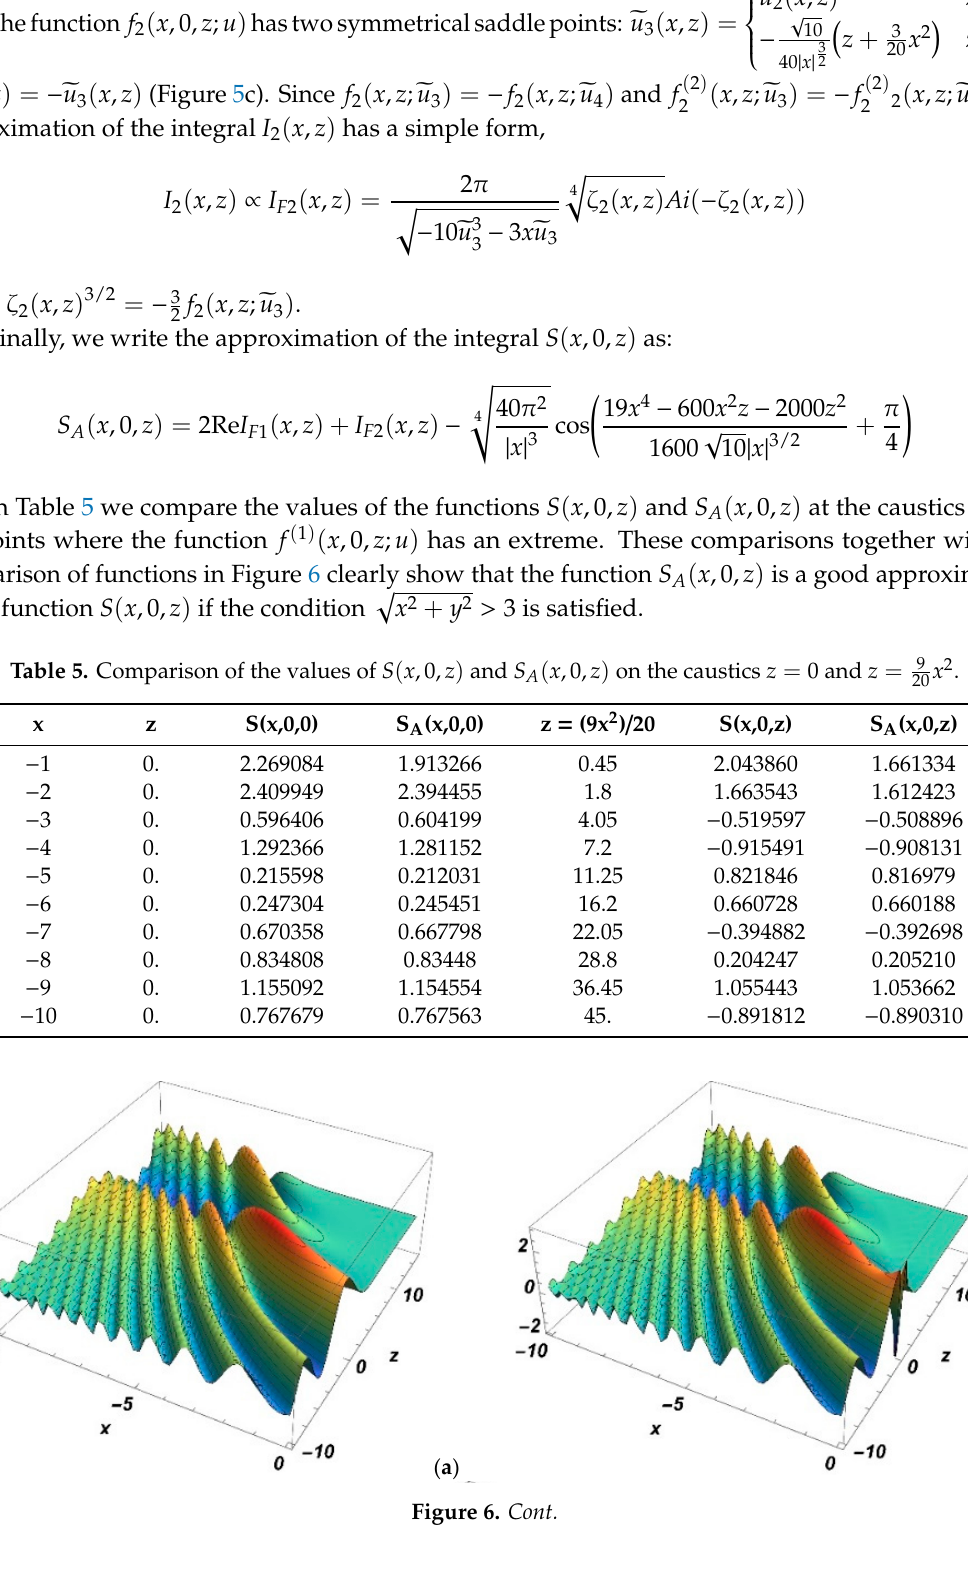
Figure 6. Function